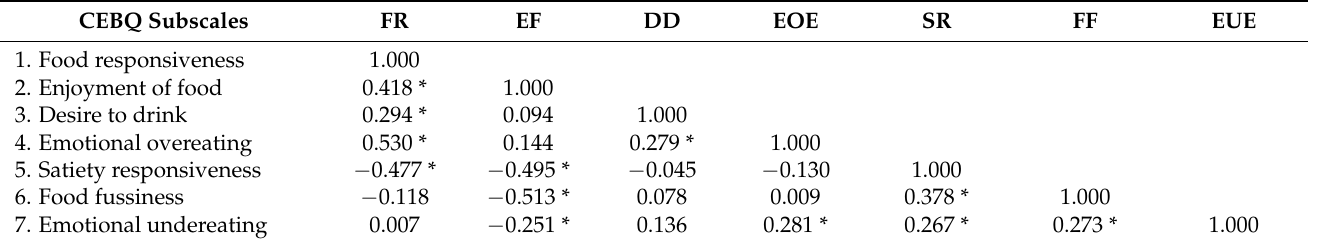
Table 2. Pearson’s correlations between the subscales of child eating behavior questionnaire. CEBQ